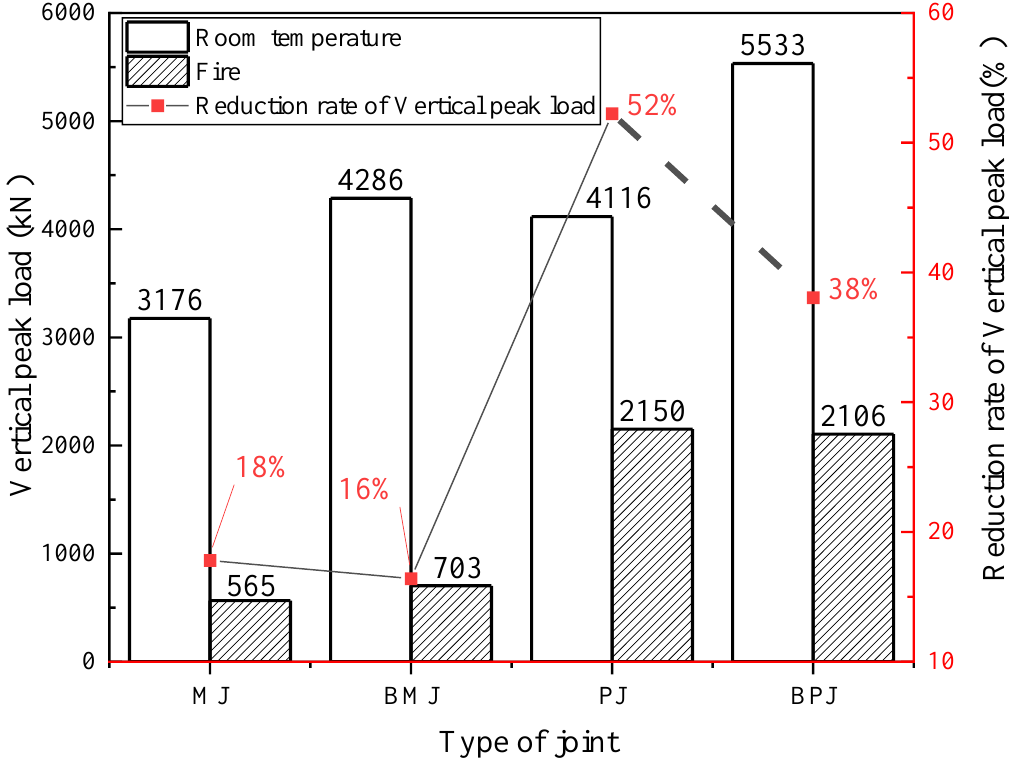
Figure 13. Flexural bearing capacity of four joints under a fire of 120 min and at room tempera- ture.